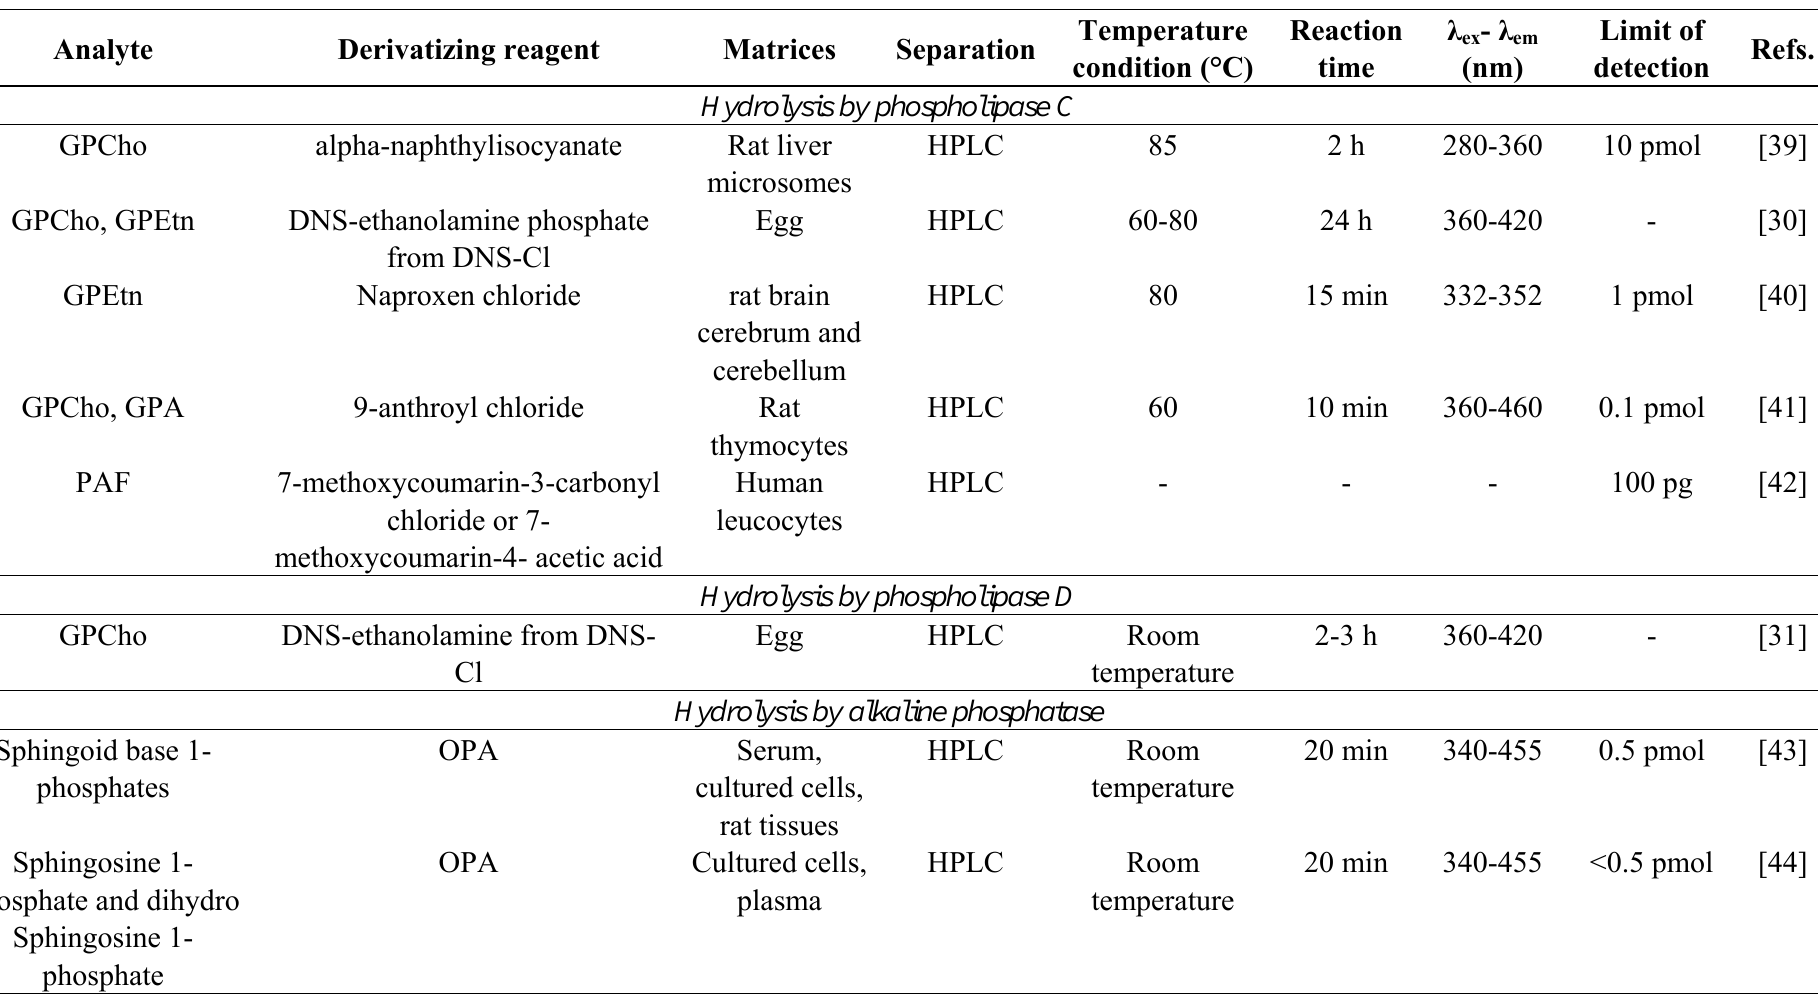
Table 2. Fluorescence derivatizations after hydrolysis used in HPLC and